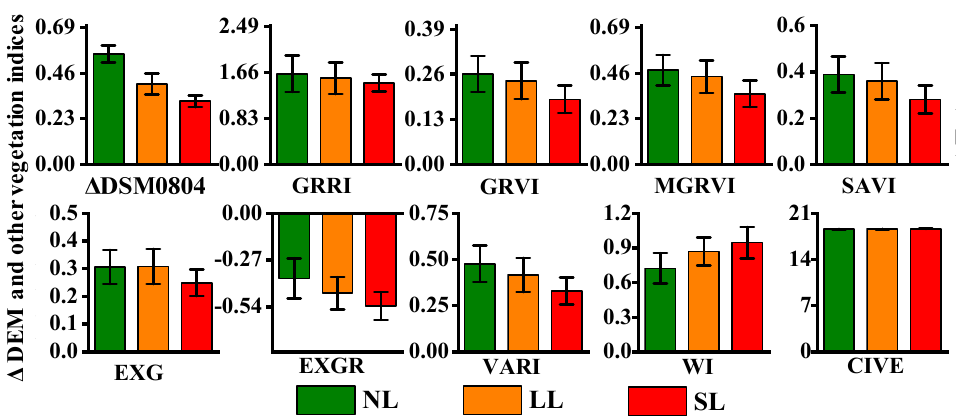
Figure 11. Histograms of nine vegetation indices for different degrees of lodging. The green solid curve corresponds to the NL plot after lodging and is basically consistent with the histogram of the plot before lodging (gray dotted curve). The yellow curve corresponds to LL and red to SL land. With increasing degree of lodging, some vegetation indexes peak at higher values, whereas others peak at lower values.